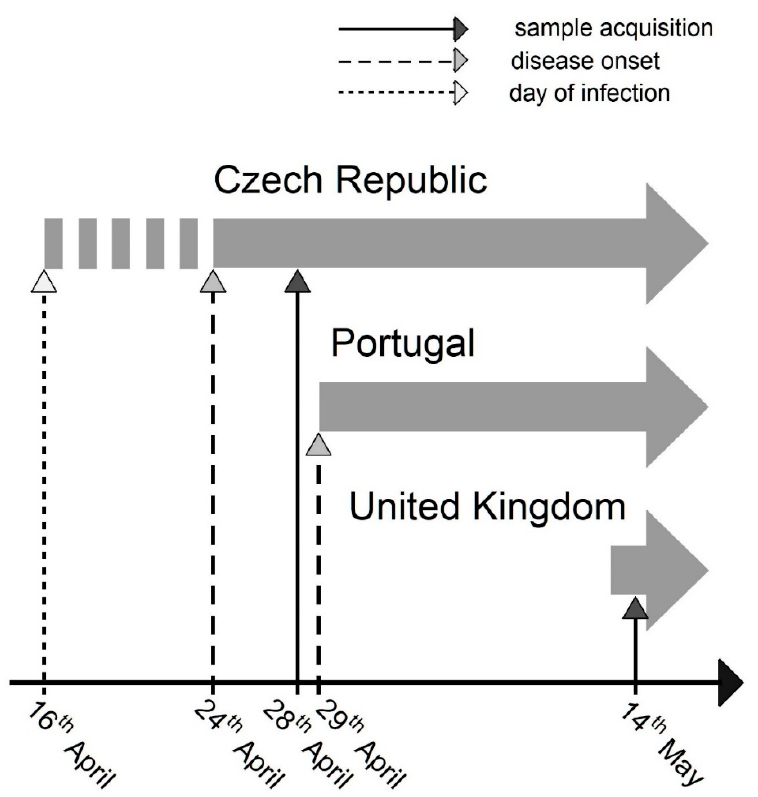
Figure 3. Timeline of the earliest reported Monkeypox virus infections from the European outbreak; only cases with no direct link to Africa were considered. Concerning the case from the Czech Republic, we provide three different dates: “sample acquisition” refers to a date when biological sample was acquired for molecular analyses; “disease onset” refers to a date when first symptoms of the disease were manifested; “day of infection” refers to a date when the infection was presumably transmitted (risk contact). Concerning the Portugal and United Kingdom cases, we report dates that were publicly available [9,10].